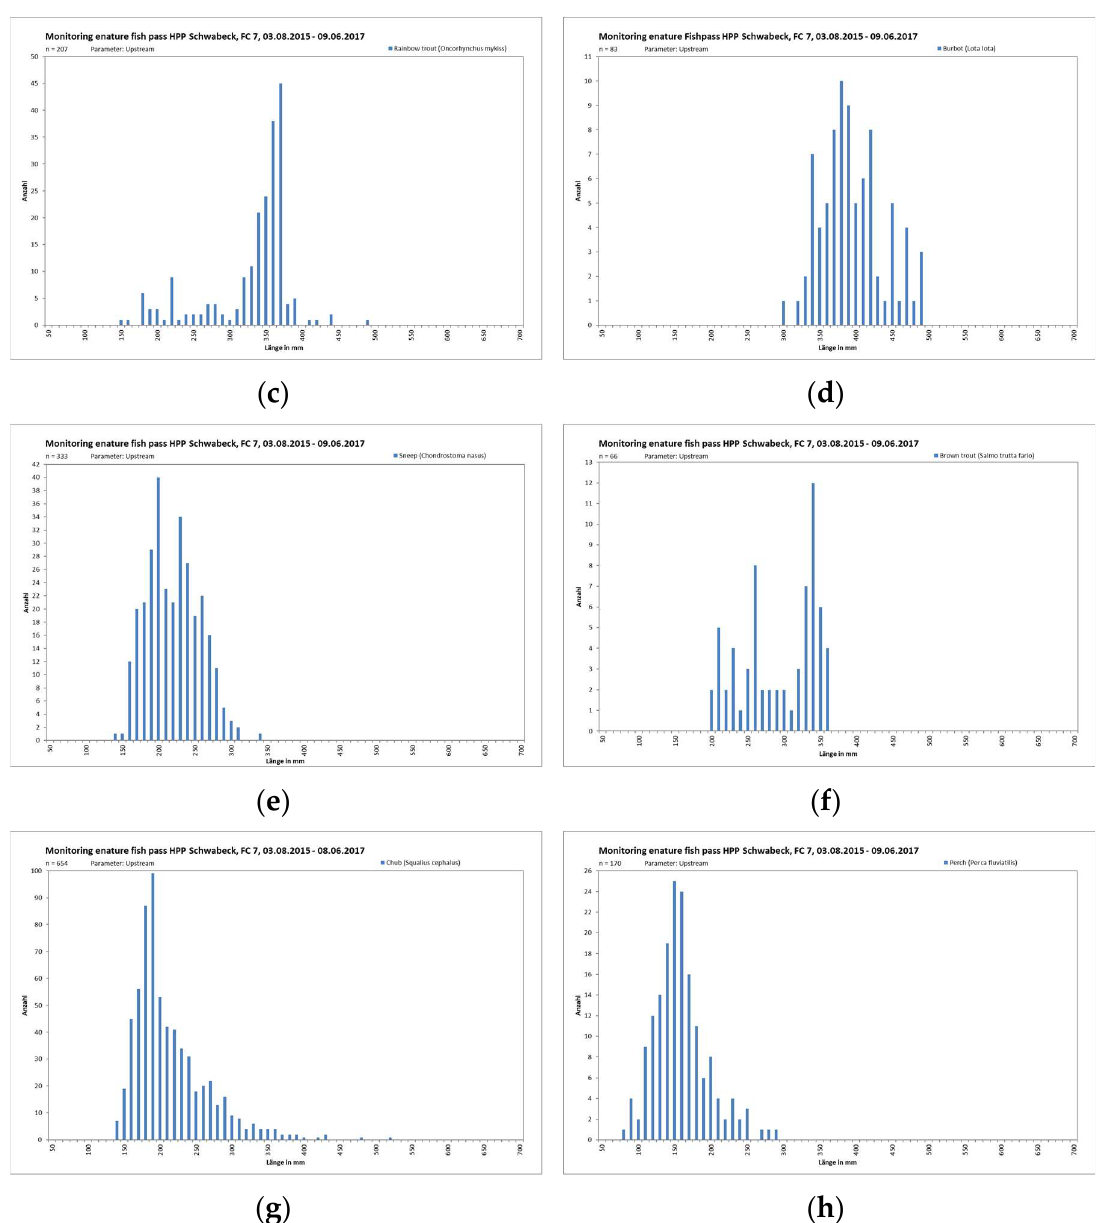
Figure 13. Length frequency distributions of detected fish species, selected examples: (a) A. brama , (b) R. rutilus , (c) O. mykiss , (d) L. lota , (e) C. nasus , (f) S. trutta fario , (g) S. cephalus , (h) P. fluviatile.